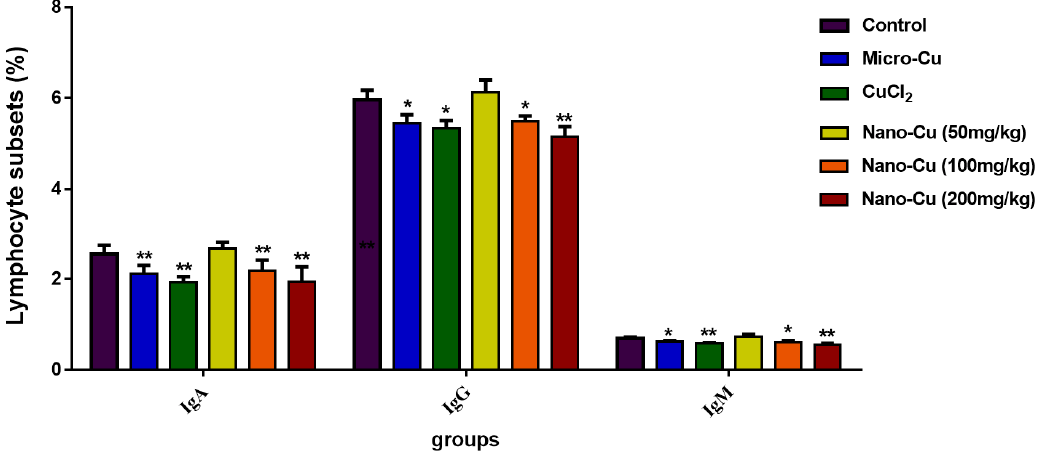
Figure 4. Immunoglobulin levels of IgA IgG, and IgM in rats treated with oral administration for 28 consecutive days. * p < 0.05 and ** p < 0.01. Values represent means ± SD ( N = 10).